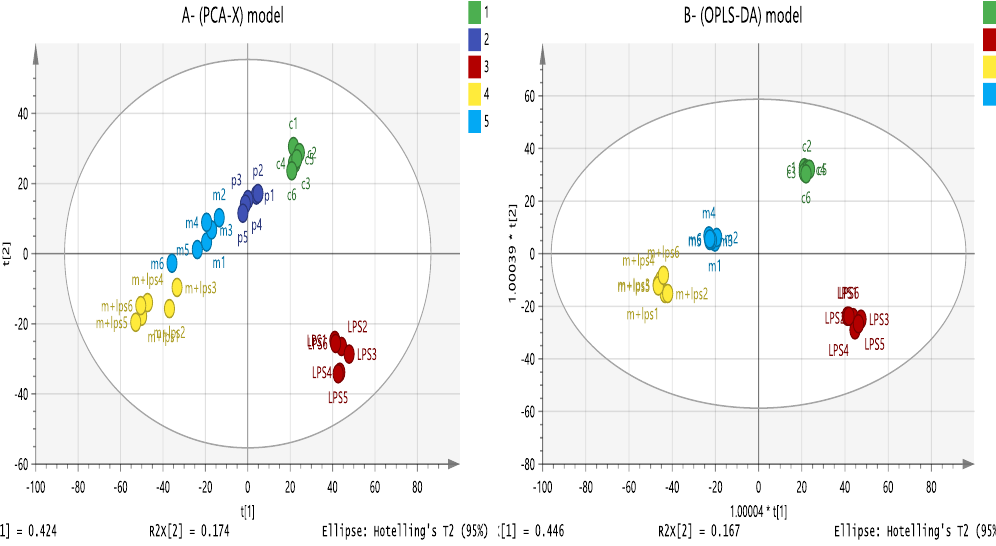
Figure 6. ( A ) PCA-X vs. ( B ) OPLS-DA score plots of THP-1 cells. The figures show a clear separation between control, pooled, and treatment groups (LPS, melittin, and LPS + melittin) based on 955 polar metabolites separated on a ZIC-pHILIC column ( n = 6). PCA score plot ( A ) has R 2 X = 0.668, Q 2 = 0.559. OPLS-DA score plot ( B ) has R 2 X = 0.744, R 2 Y = 0.99, Q 2 = 0.903. (C: control; Mel: melittin; LPS: lipopolysaccharide; Mel + LPS: melittin and LPS combination treatments; P = pooled samples). PCA: principal component analysis.